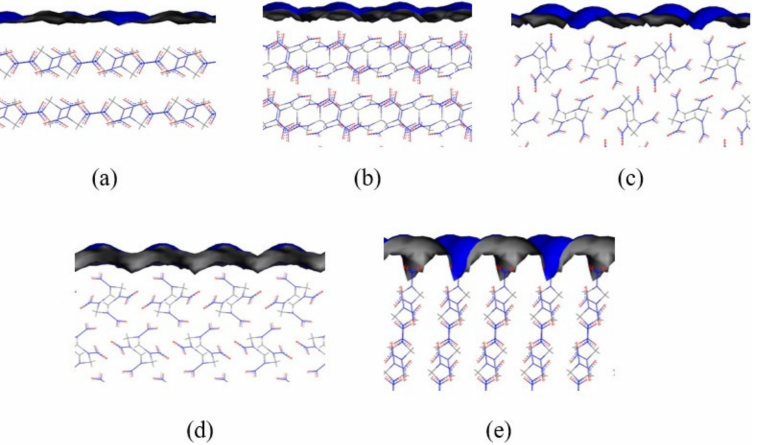
Figure 3. Packing structure and solvent accessible surface of different crystal planes. ( a ) {1 0 − 2}